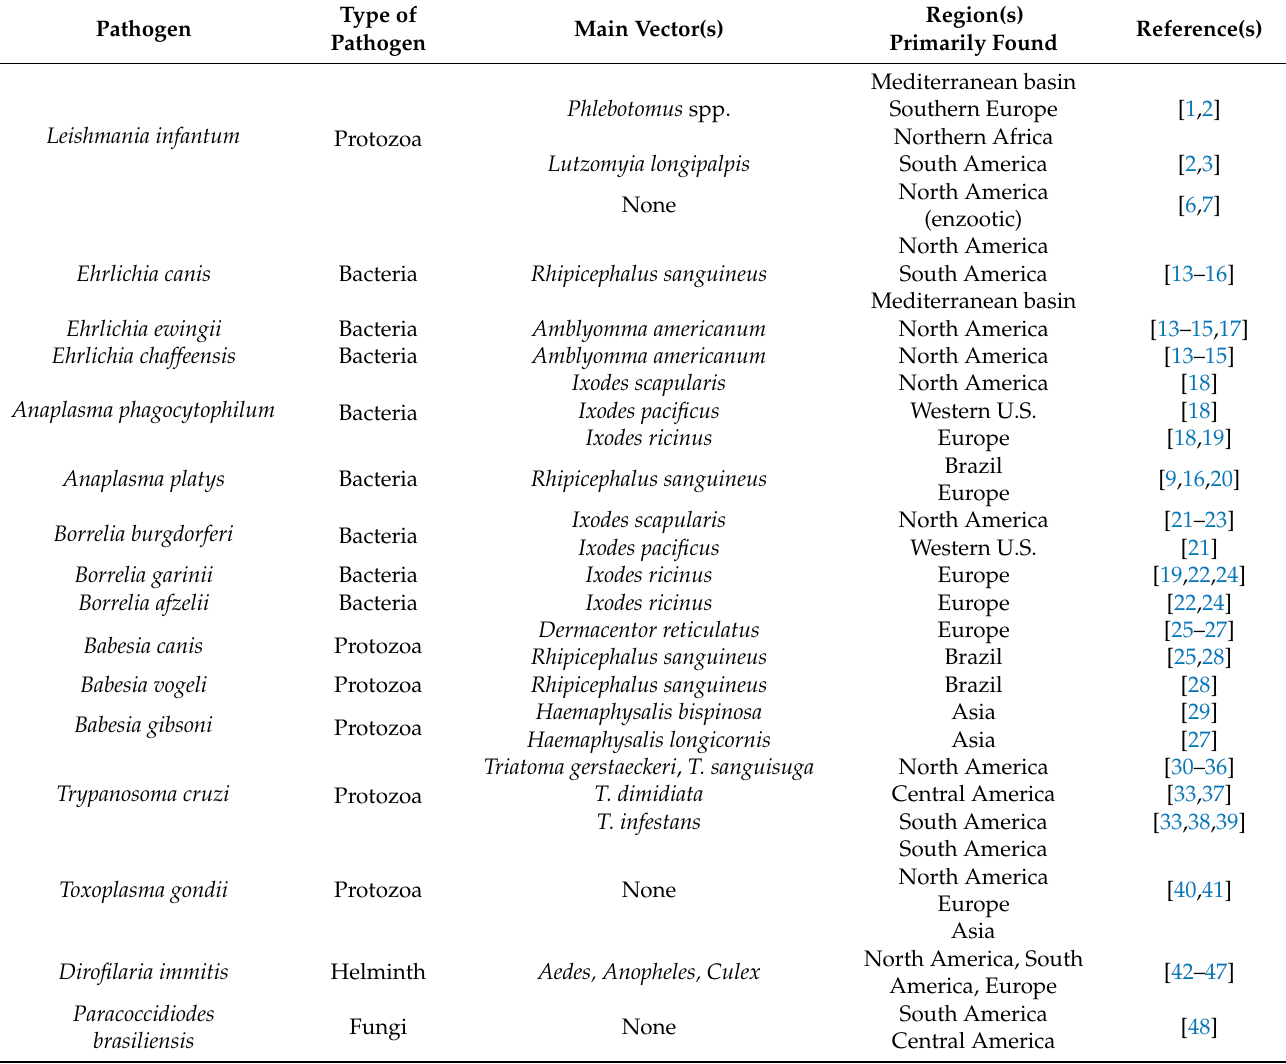
Table 1. Main pathogens involved in co-infection with canine